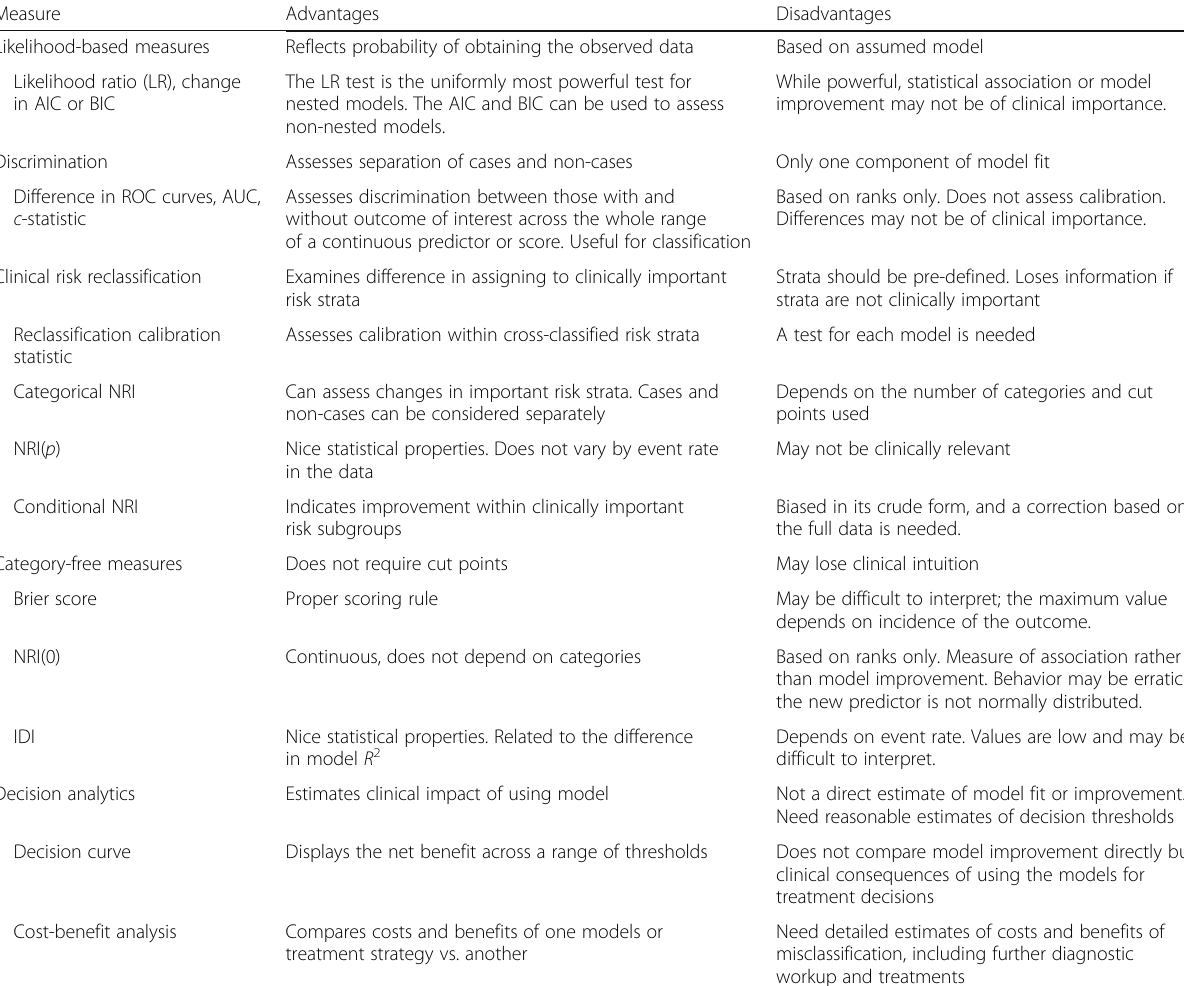
Table 1 Summary of performance measures for quantifying added